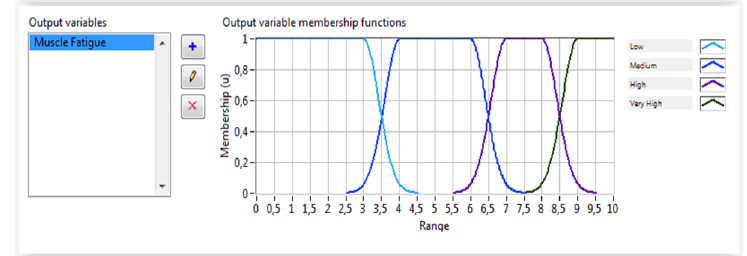
Figure 11. Muscle fatigue